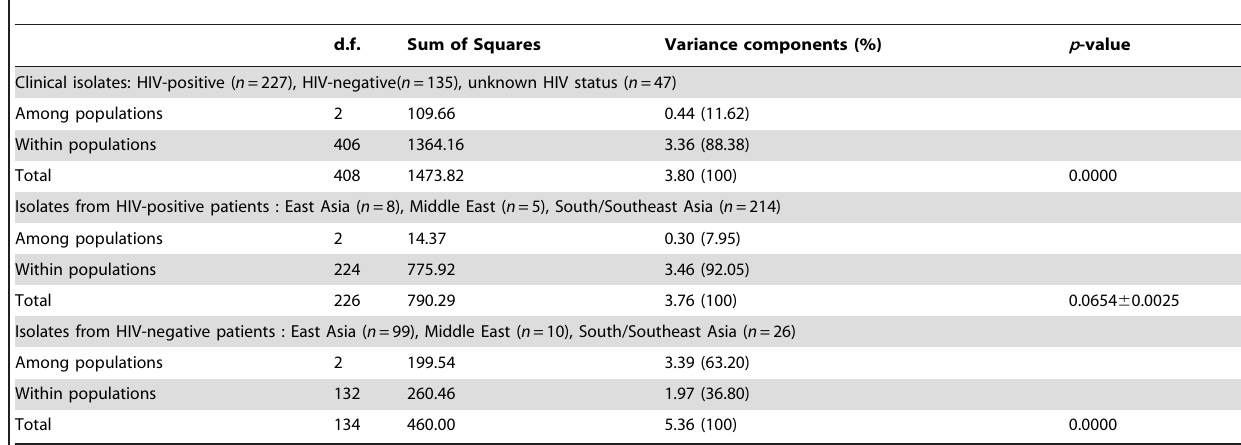
Table 4. Analysis of Molecular Variance (AMOVA) of Asian C . neoformans according to HIV status and geographical origin.